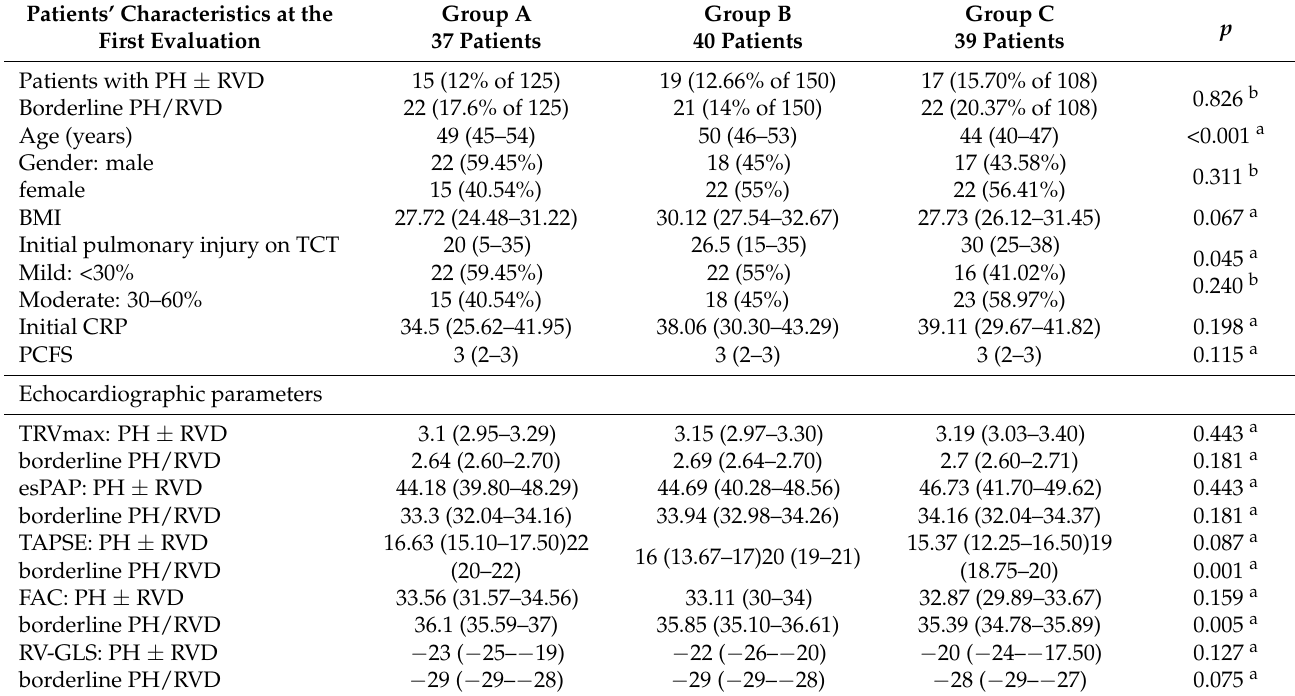
Table 3. Baseline characteristics of patients from the first, second, and third wave of COVID-19. Patients’ Characteristics at the First